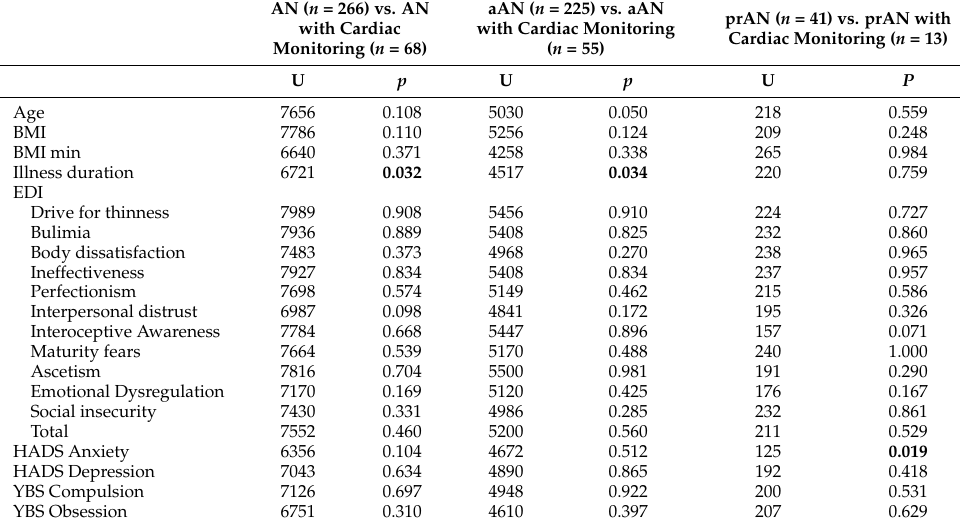
Table 3. Representativity of the sample with cardiac monitoring. Comparison of clinical characteris- tics of all patients with anorexia nervosa (AN), acute AN (aAN) or partially recovered AN (prAN) and the sample with continuous cardiac monitoring. Significant p -values are in